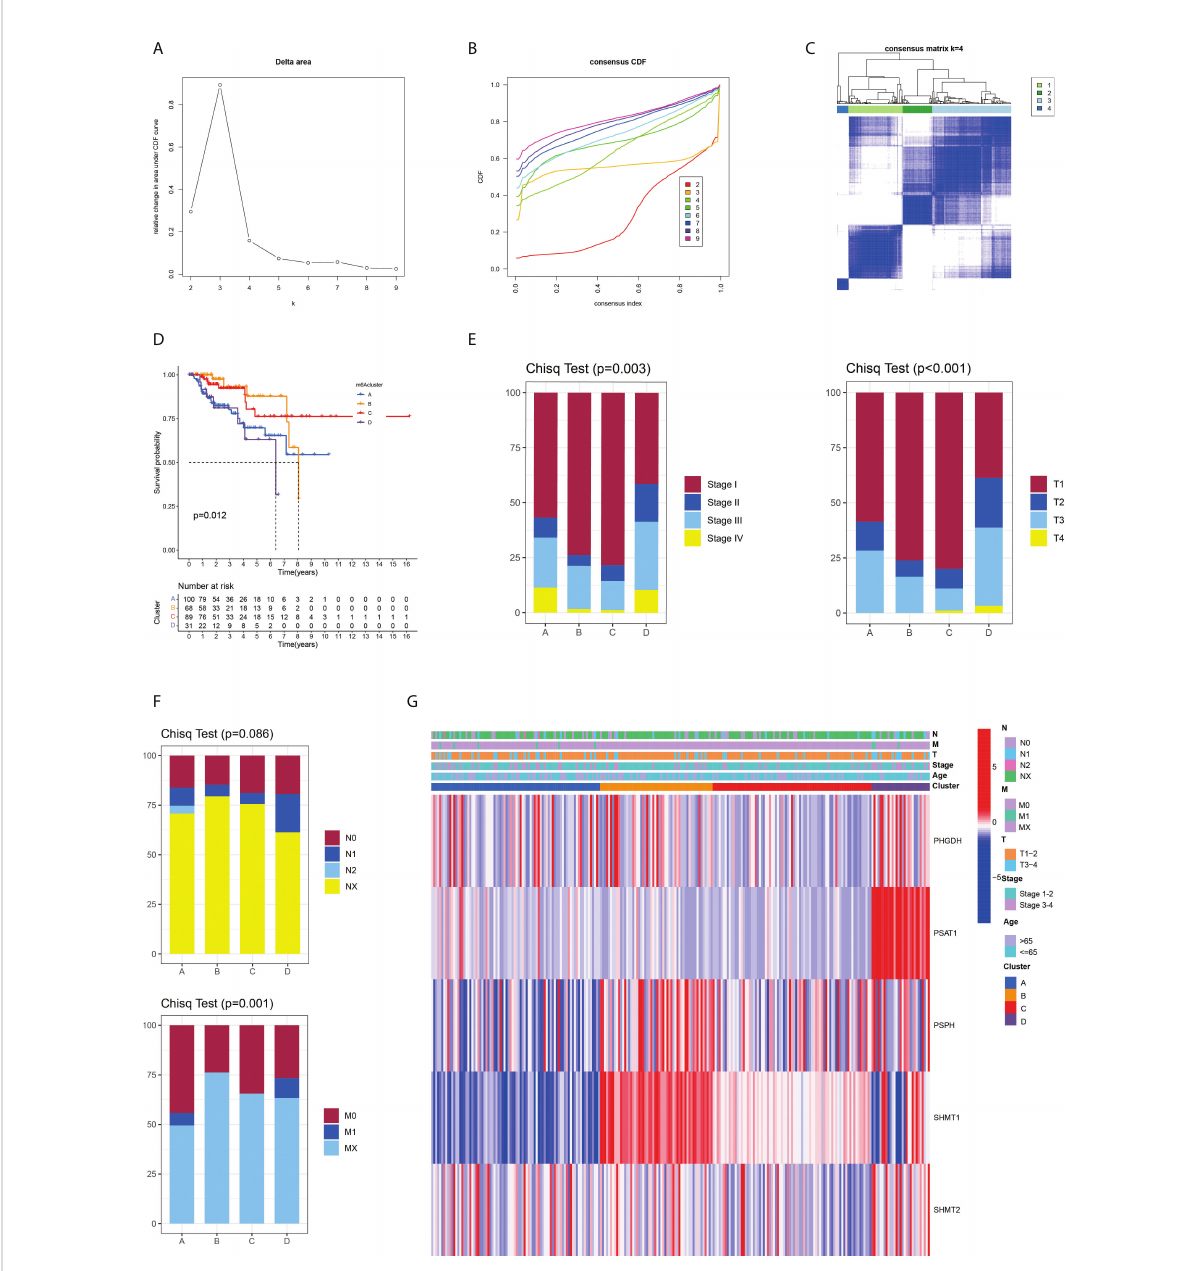
FIGURE 2 Identi fi cation and clinical correlation of various serine metabolic molecular patterns of pRCC. (A) Delta region graph showing the relative change in the area under the CDF curve for K = 2 – 9. (B) Consensus clustering cumulative distribution function (CDF) for K = 2 – 9. (C) Consensus clustering matrix for K = 4. (D) Kaplan – Meier overall survival (OS) curve for 289 patients with pRCC in the cluster A/B/C/D subgroups. Patients in cluster B had the best OS (p = 0.012). (E, F) Difference in the proportion of cases with different pathological stages (Chisq Test, p = 0.003), T stage (Chisq Test, p < 0.001), M stage (Chisq Test, p = 0.001), and N stage (Chisq Test, p = 0.086) from TCGA among A, B, C, and D clusters. (G) On the basis of the results of the cluster analysis, the heatmap showed the correlation with clinicopathological characteristics. Red represents a high expression of SMGs, and blue represents a low